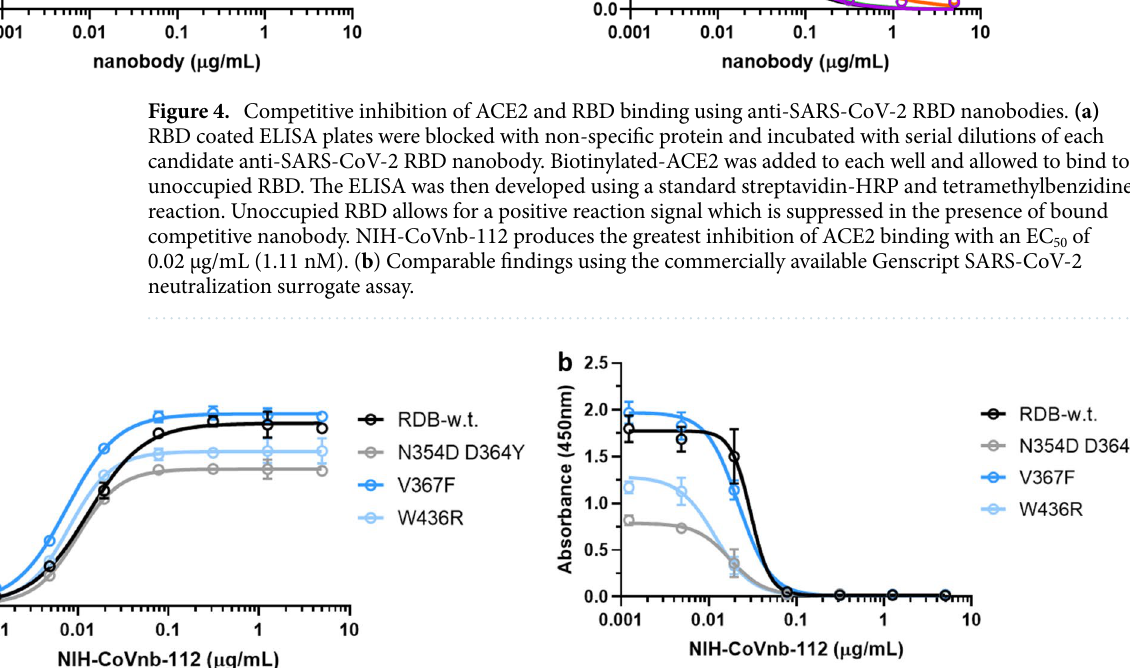
Figure 5. Interaction of NIH-CoVnb-112 with SARS-Cov-2 Spike Protein RBD variants. (a) Binding of NIH-CoVnb-112 to RBD “wild type” and 3 variant forms of the RBD had similar affinity, with half maximal binding at approximately 0.01 µg/mL ( b) Competitive inhibition assay: RBD “wild type” and 3 variant forms of the RBD coated ELISA plates were blocked with non-specific protein and incubated with dilutions of the lead candidate anti-SARS-CoV-2 RBD nanobody NIH-CoVnb-112. Biotinylated-ACE2 was added to each well and allowed to bind to unoccupied RBD. The ELISA was then developed using a standard streptavidin-HRP and tetramethylbenzidine reaction. Unoccupied RBD allows for a positive reaction signal which is suppressed in the presence of bound competitive nanobody. NIH-CoVnb-112 inhibited ACE2 binding to each of the variants with a similar EC 50 of 0.02 µg/mL (1.11